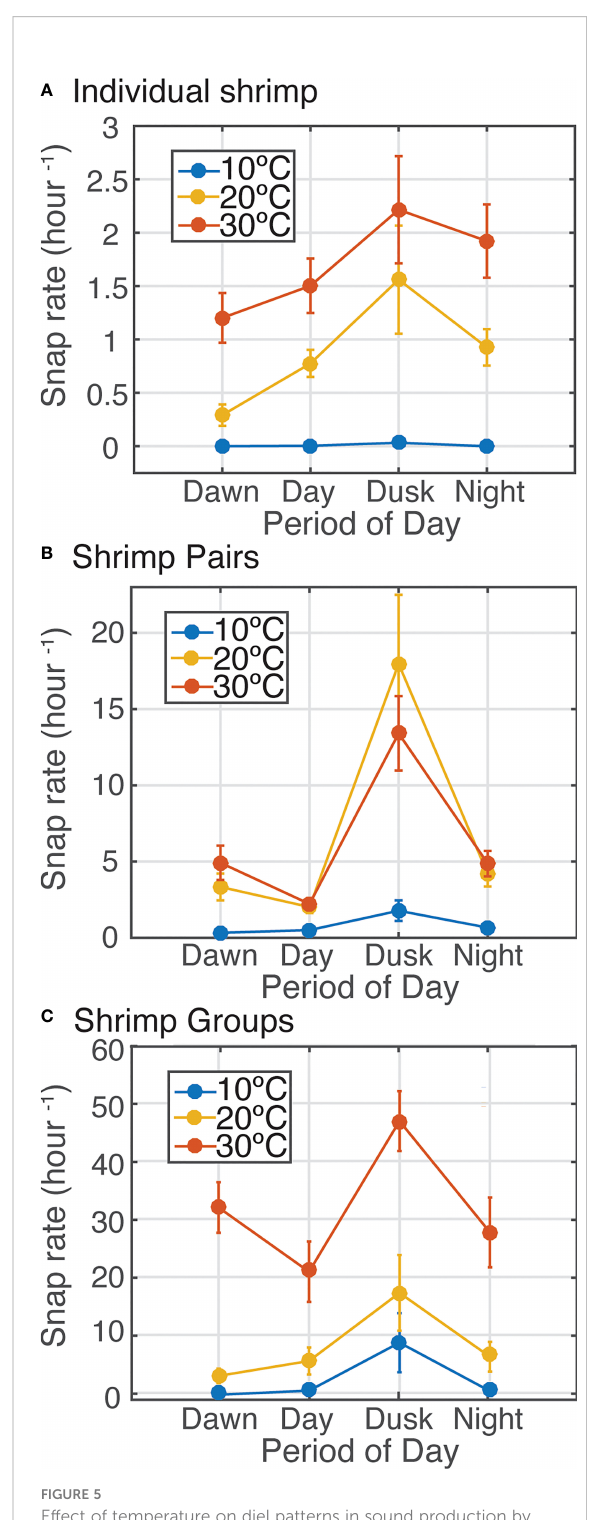
FIGURE 5 Effect of temperature on diel patterns in sound production by snapping shrimp measured in three experiments under different social contexts: (A) solitary, (B) pairs, and (C)